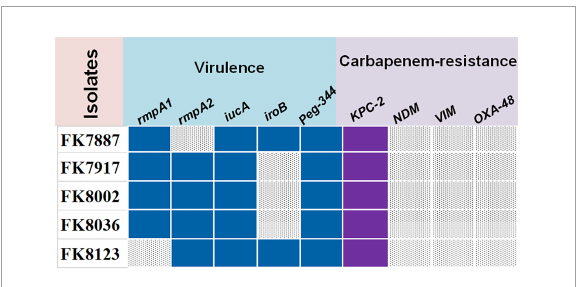
FIGURE1 The virulence and carbapenem-resistant genes of five carbapenem-resistant Klebsiella pneumoniae (CRKP) strains. Blue color represents virulence genes, purple color represents carbapenem-resistant genes, and gray color represents don’t carry the corresponding